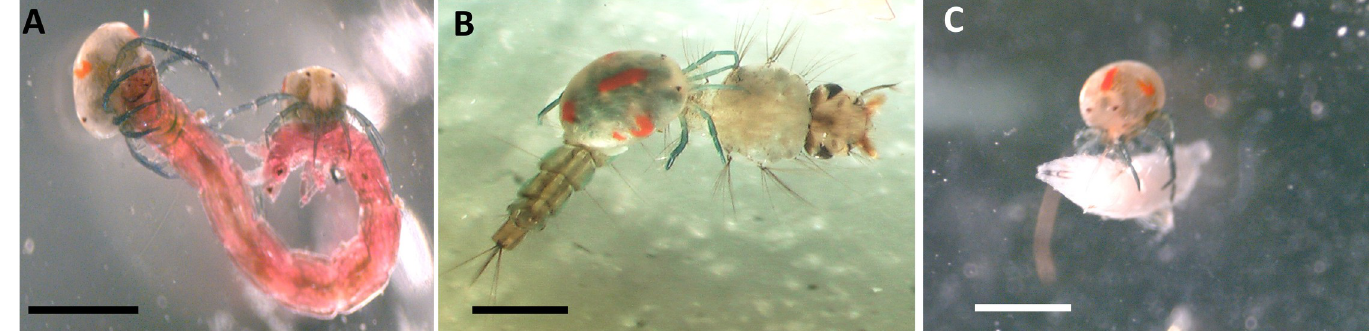
Fig 2. Lebertia quinquemaculosa preying upon organisms in laboratory feeding experiments. A, Chironomus riparius ; B, Culex pipiens , and C, Drosophila melanogaster . Calibration bars = 1 mm.